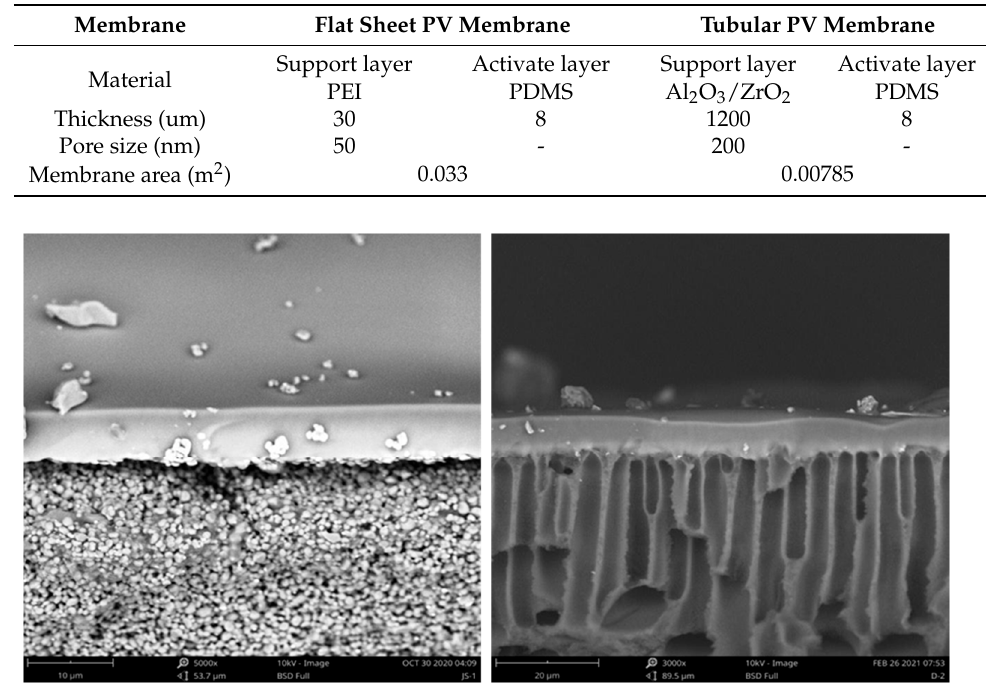
Figure 1. SEM images of the virgin tubular PDMS/Al 2 O 3 /ZrO 2 composite membrane ( left ) and flat-sheet PDMS/PEI composite membrane ( right ). Table 1. Characteristics of the membranes used in this study.